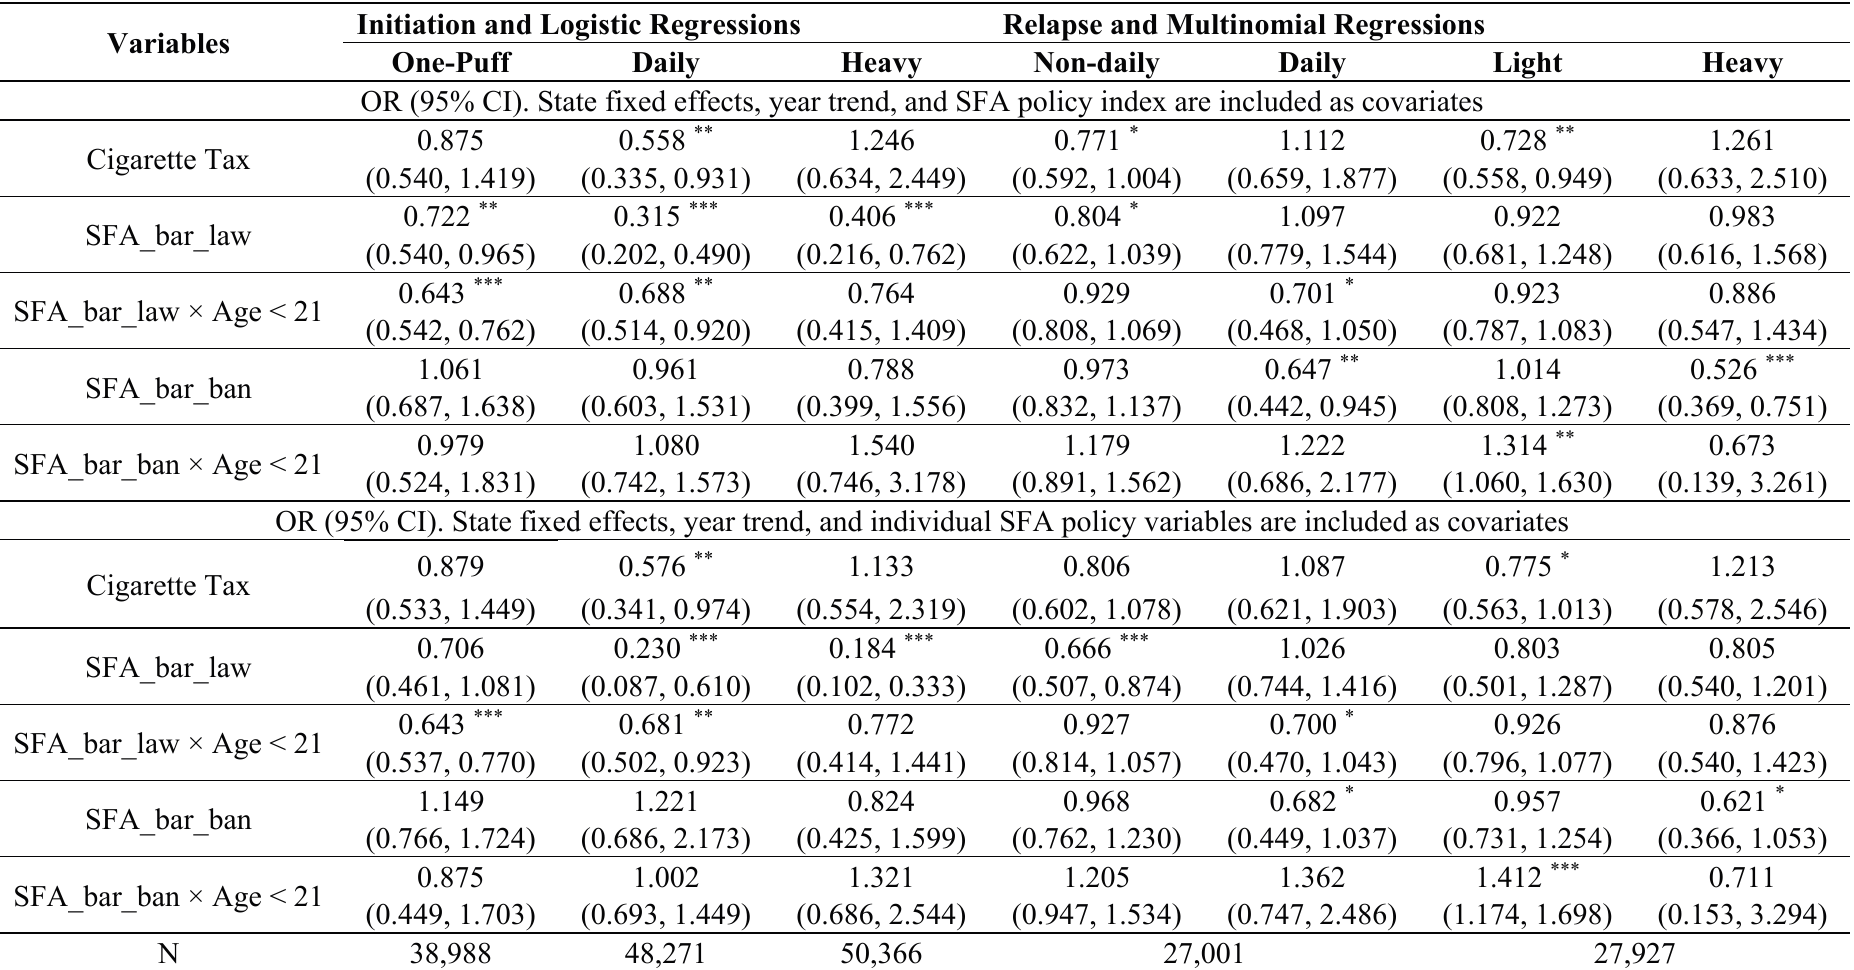
Table 4. The effects of SFA in bars on smoking initiation_NLSY97, 1997–2009, sensitivity